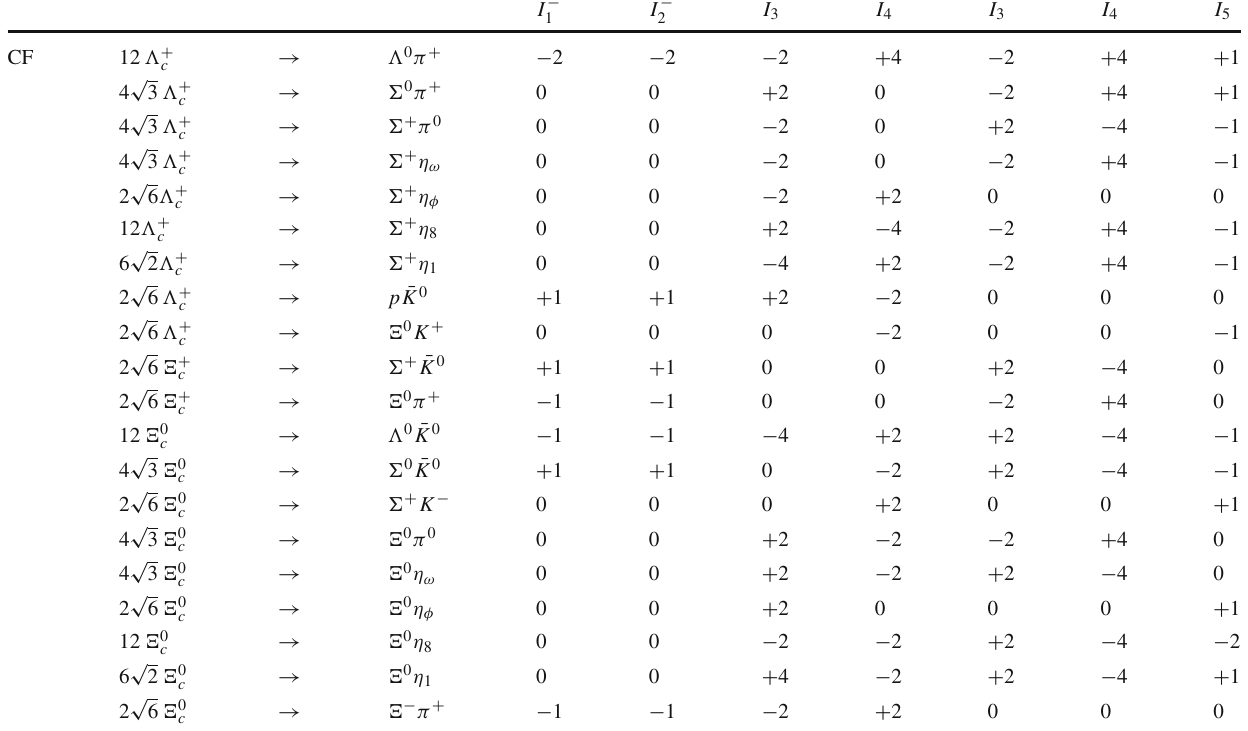
Table 3 Values of the seven topological tensor invariants for the antitriplet charm baryon decays B c ( 3 ) → B ( 8 ) + M ( 8 , 1 ) induced by the CF flavor transitions ( c → s ; d → u ) . We have always factored out the products of the normalizing denominator factors appearing in